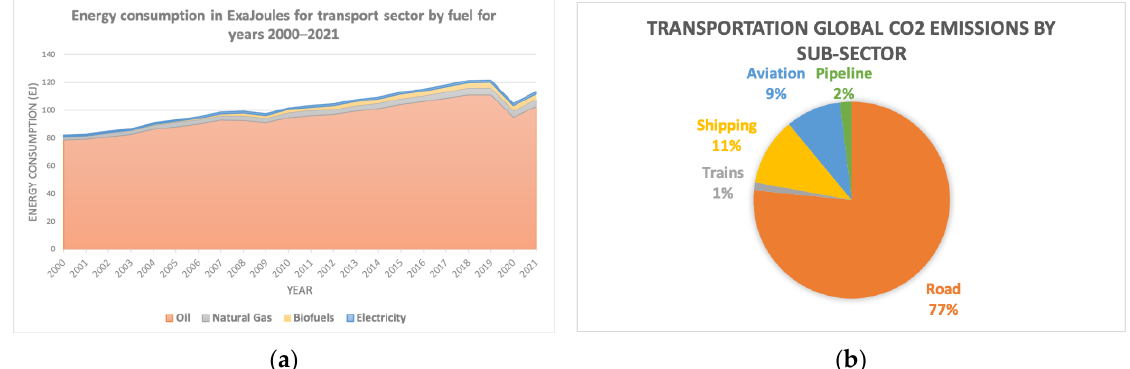
Figure 1. Global energy and CO 2 emissions for the transportation sector ( a ) Energy consumption consumed in the transportation sector in a 21-year scope [1]; ( b ) CO 2 emissions by subsector reveal- ing the influence of road transport on greenhouse gases.